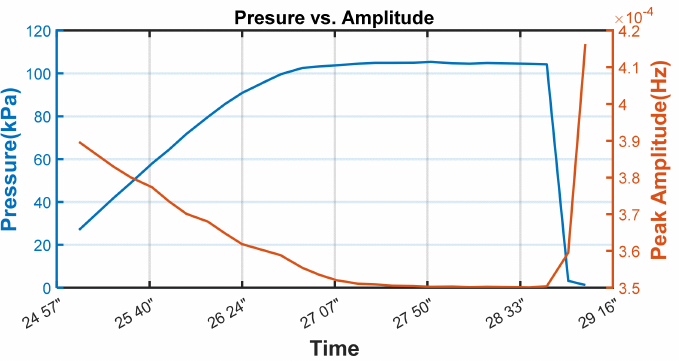
Figure 7. Comparison between pressure and amplitude of the major peak (test